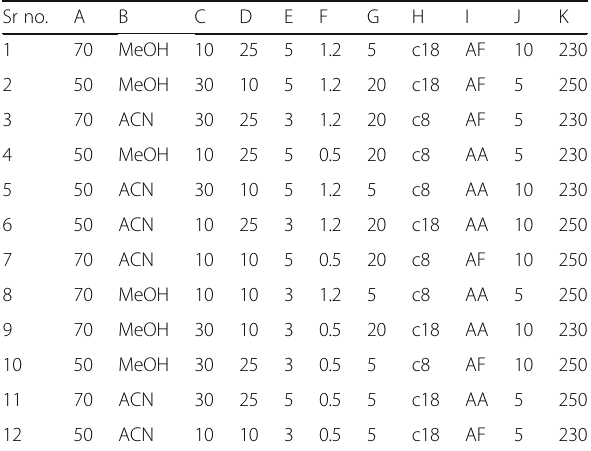
Table 1 Plackett – Burman design for screening of Primary